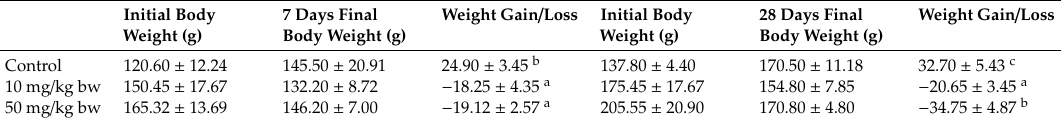
Table 1. Weight changes of male rats following administration of Ag-NP.